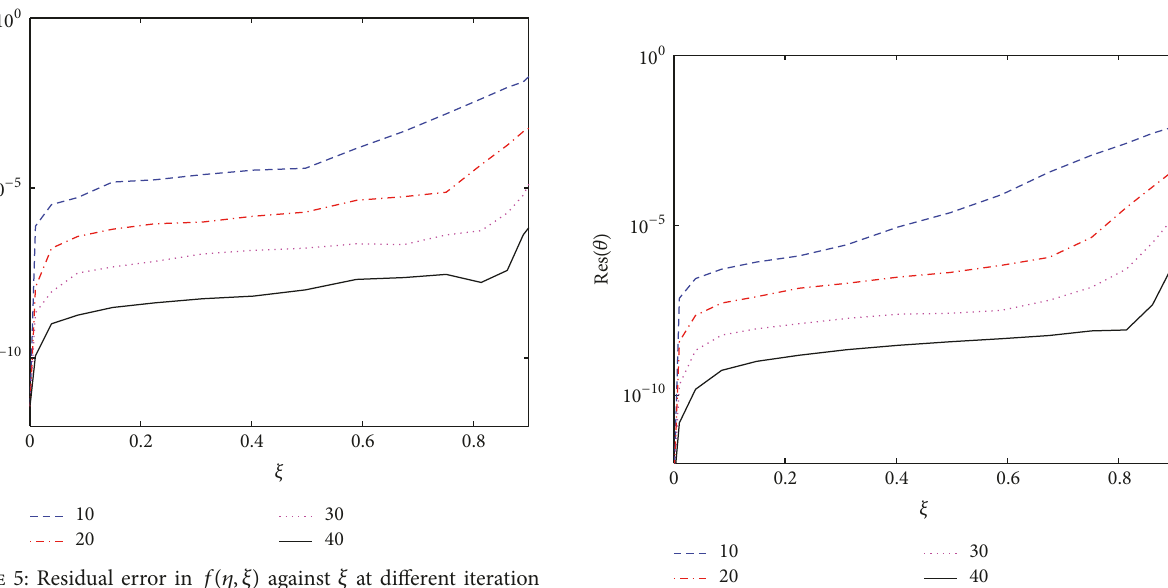
Figure 7: Residual error in 𝜃(𝜂, 𝜉) against 𝜉 at different iteration levels ( 𝜆 = 1, 𝜎 = 𝛾 = 0.5, Pr = 3, Sc = 2, ℏ = −0.5